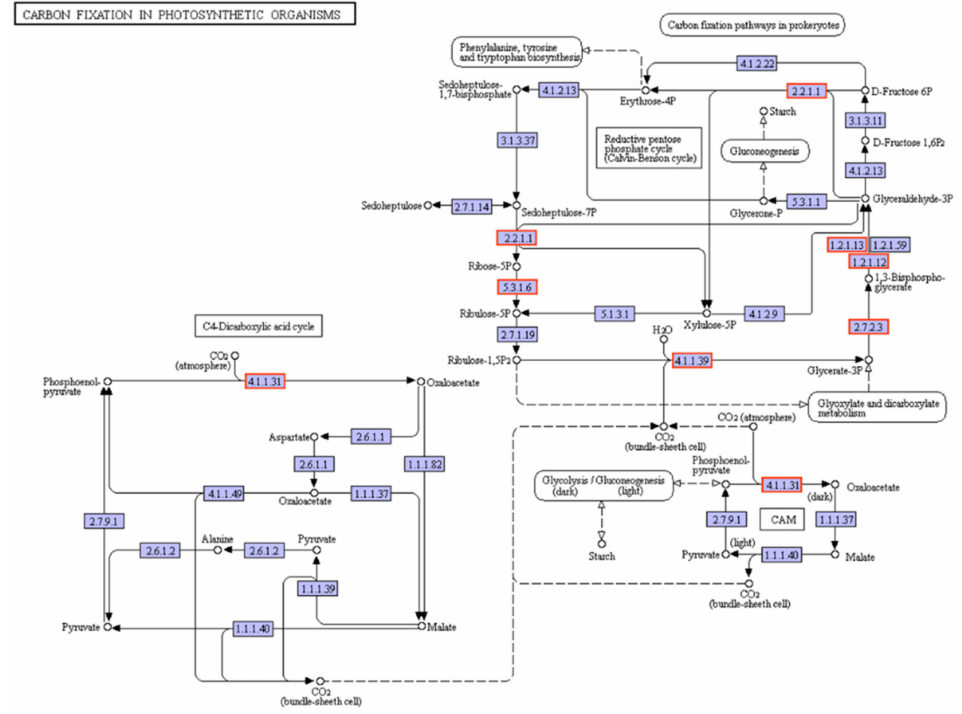
Figure 7. E ff ect of CTS on DEGs of carbon fixation in photosynthetic organisms in leaves of annual ryegrass. Definition of genes encoding enzymes: (1) 2.2.1.1, transketolase (TKT); (2) 1.2.1.13, glyceraldehyde-3-phosphate dehydrogenase (GAPDH / GAPA); (3) 5.3.1.6, ribose-5-phosphate isomerase 2 (RPI2); (4) 4.1.1.39, ribulose bisphosphate carboxylase small chain (rbcS); (5) 2.7.2.3, phosphoglycerate kinase (PGK); (6) 4.1.1.31, phosphoenolpyruvate carboxylase 1(PPC1). Red means an